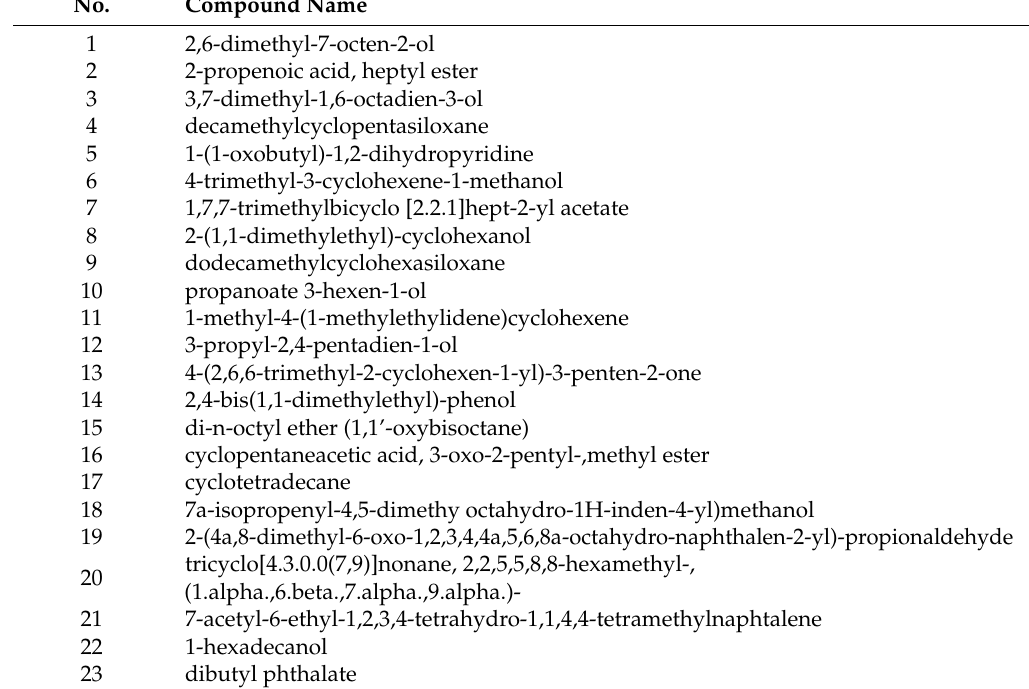
Table 3. Head Space, Solid-Phase Microextraction, Gas Chromatography, and Mass Spectrometry (HS-SPME-GC-MS) analysis results, raw